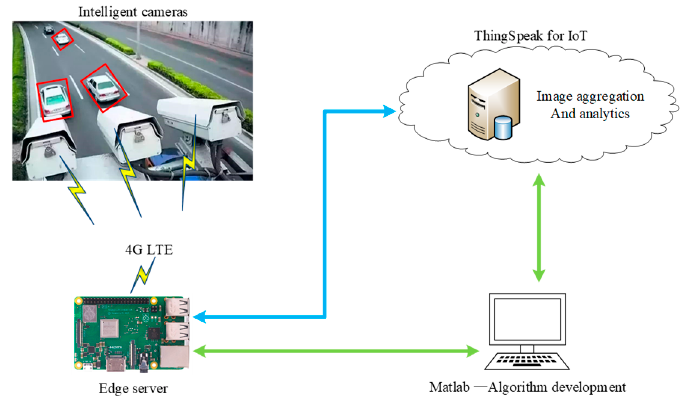
Figure 6. Structure of test for DNN-based queue length estimation.